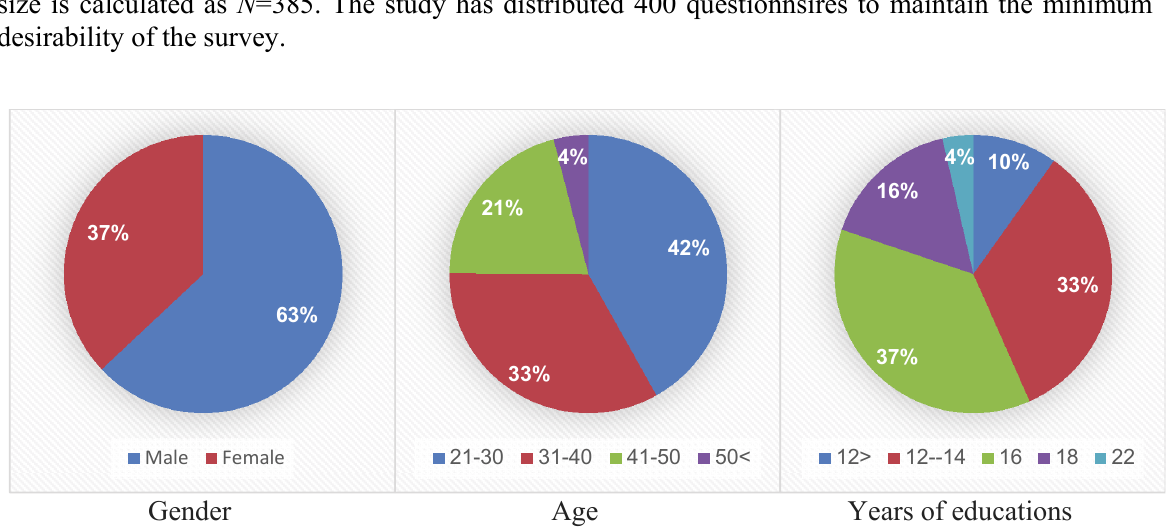
Fig. 1. Personal characteristics of the